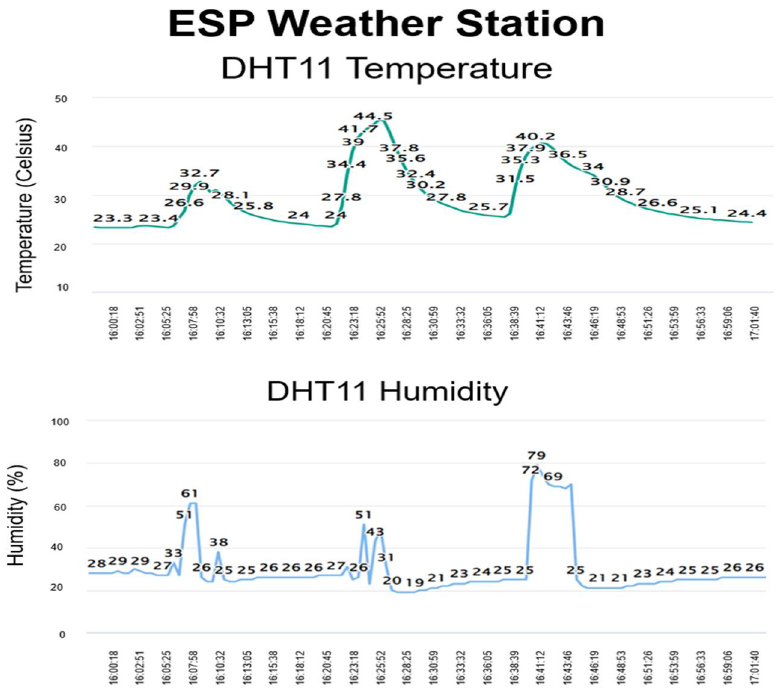
Figure 13. Sensor readings in real-time charts in web server accessed by web client.